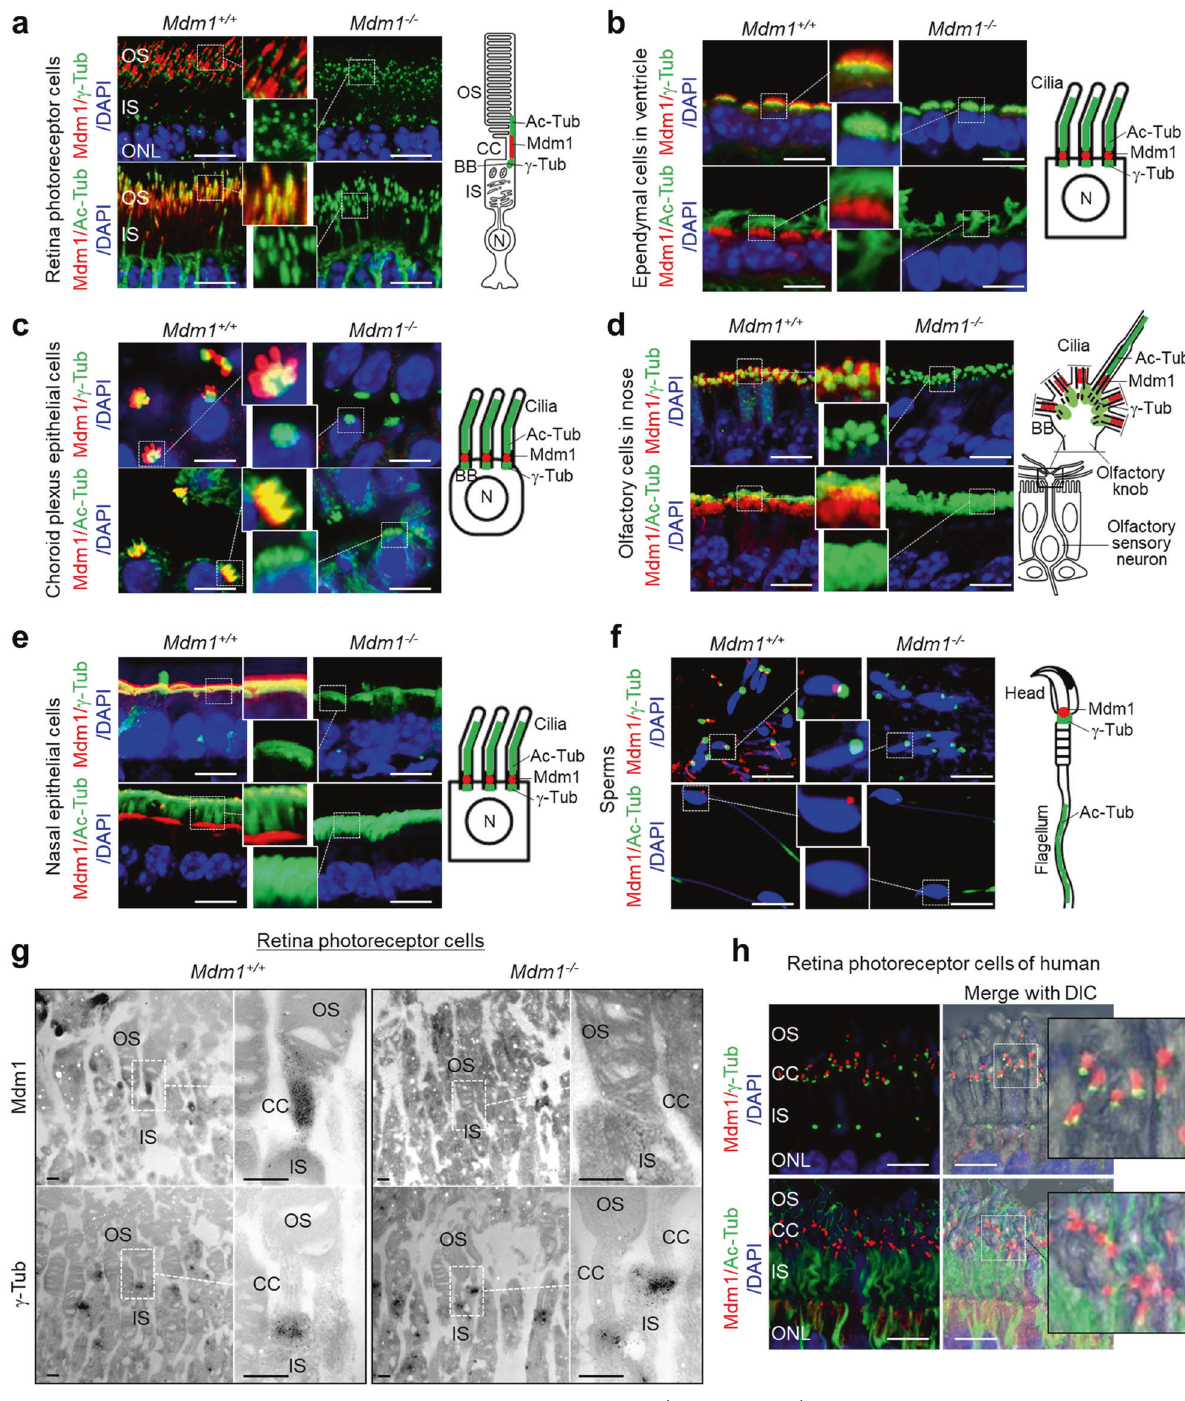
Fig. 2 Localization of Mdm1 protein in the cilia of various tissues in Mdm1 + / + and Mdm1 − / − mice. Formalin- fi xed paraf fi n-embedded tissue sections from Mdm1 + / + and Mdm1 − / − mice were stained with antibodies against Mdm1 (red), γ -tubulin (green), or acetylated-tubulin (green) and then counterstained with DAPI (blue) to visualize the nuclei. Representative images are shown ( n > 8 per group). The expression of each protein was analyzed by confocal microscopy and the localization of each is shown with schematic cartoons ( a – f ). a Photoreceptor cells of the retina. b Ependymal cells of the ventricle. c Choroid plexus epithelial cells. d Olfactory cells in the nose. e Nasal epithelial cells. f Sperm in the testis. Scale bar, 10 μ m. g Immunoelectron microscopy was performed to determine the localization of the Mdm1 protein in photoreceptor cells of the retina. Scale bar, 500 nm. h Immuno fl uorescence staining of Mdm1 (red), γ -tubulin (green) or acetylated-tubulin (green) in the human retina. Scale bar, 10 μ m. OS, outer segment; IS, inner segment; CC, connecting cilium; BB, basal body; ONL, outer nuclear layer.